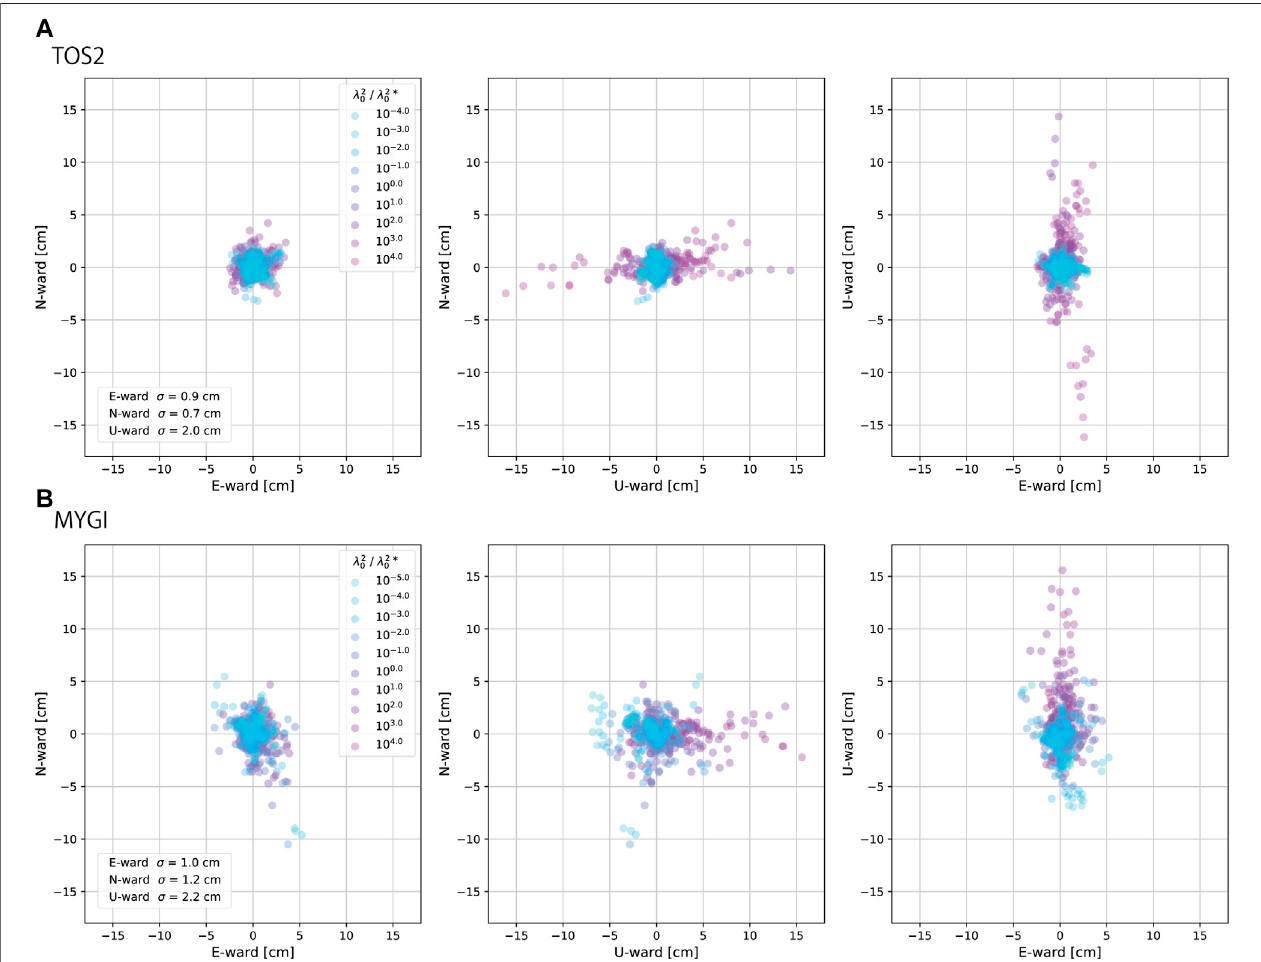
FIGURE 9 | Distributions of differences of positions of the tested models from the preferred ones at (A) TOS2 and (B) MYGI for northward-eastward (left) , northward-upward (center) , and upward-eastward (right) components. The colors of circles indicate the value of λ 2 0 / λ 2 p 0 .